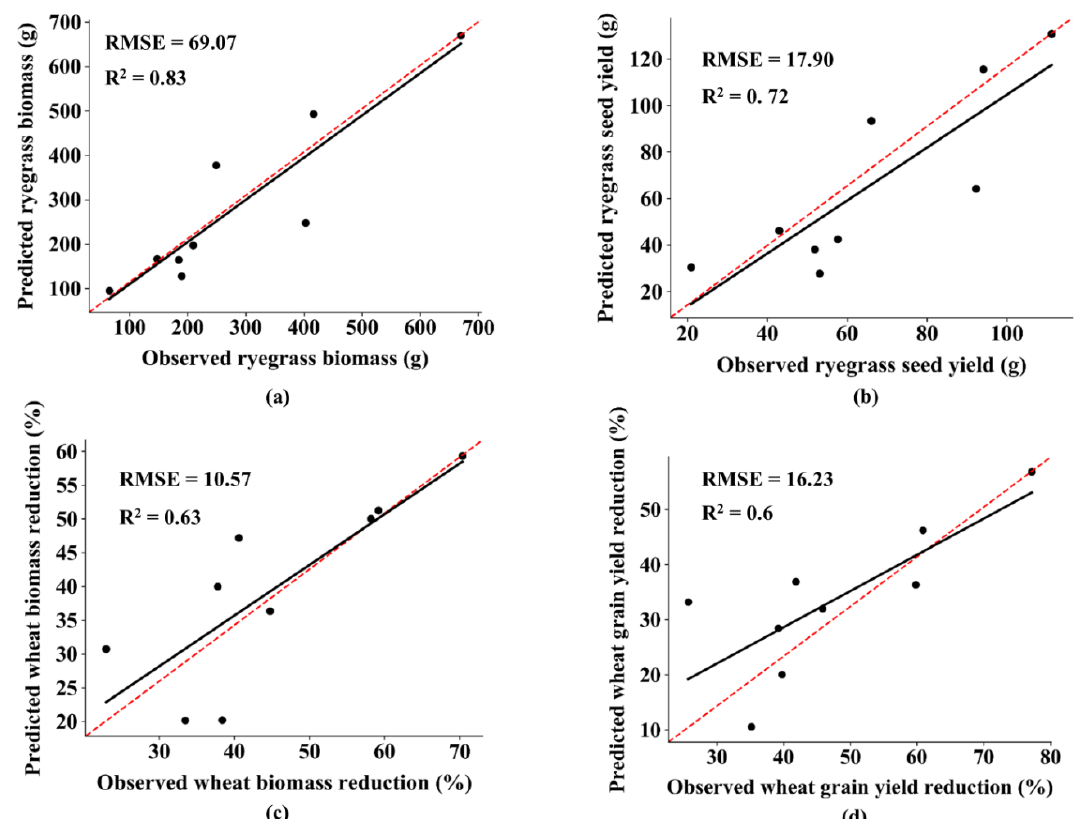
Figure 9. Predicted vs observed values in the validation experiment for different competition models pertaining to Italian ryegrass biomass ( a ), Italian ryegrass seed yield ( b ), wheat biomass reduction (%) ( c ), and wheat grain yield reduction (%) ( d ). The red-dashed line represents 1:1 slope line or reference diagonal line (expected values) and the black solid line represents the observed slope line between the predicted and observed datasets. The units of root mean square error (RMSE) values correspond to the units of respective predictor/observed values.